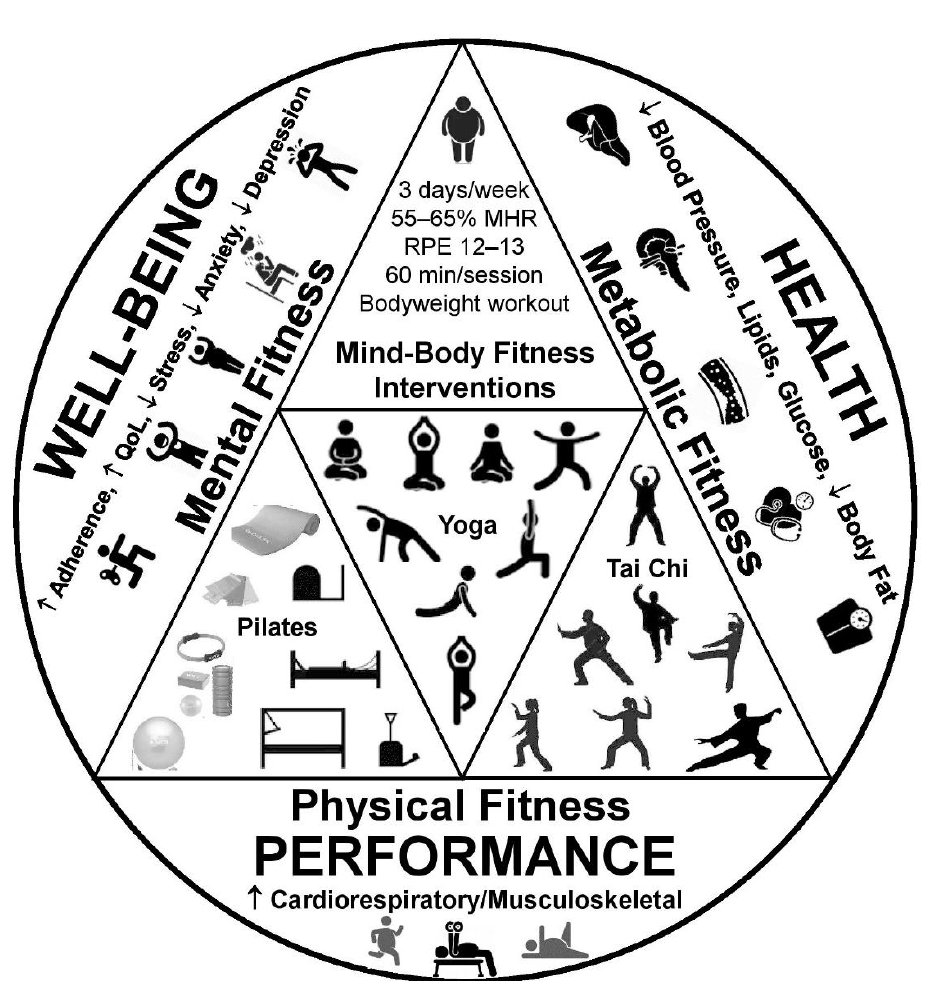
Figure 1. The psychophysiological effects of mind–body fitness interventions in overweight and obese individuals. MHR: maximum heart rate; QoL: quality of life; RPE: rating of perceived exertion [17,18,25,30,39].